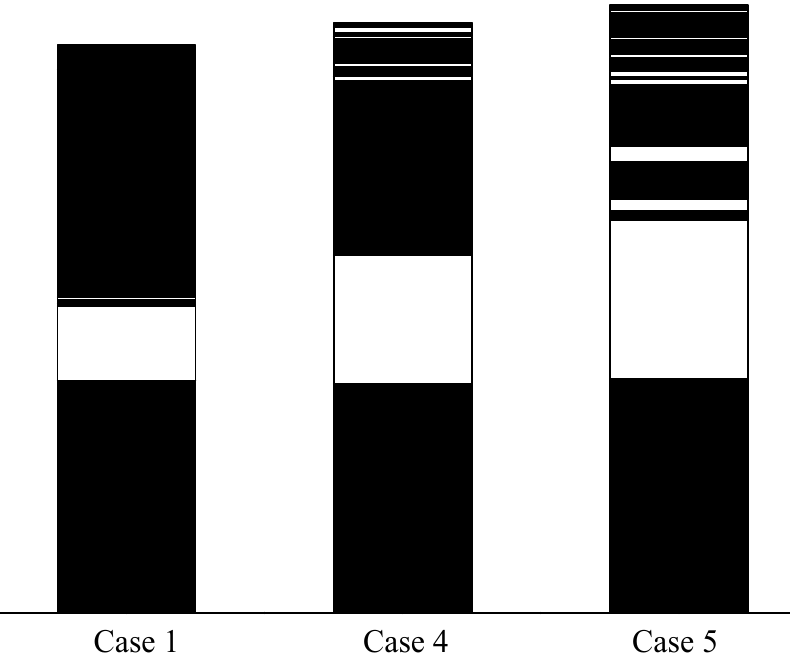
Figure 12. Distribution of ice lenses at different hydraulic conductivity.